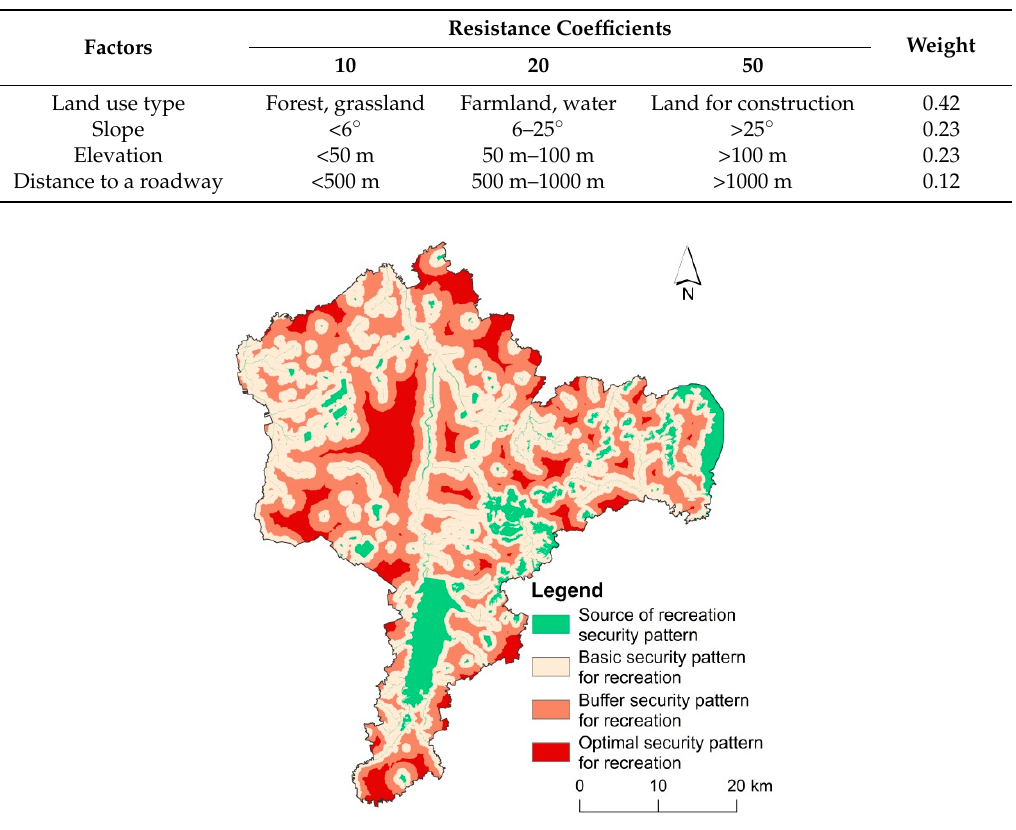
Figure 6. Recreation security pattern.